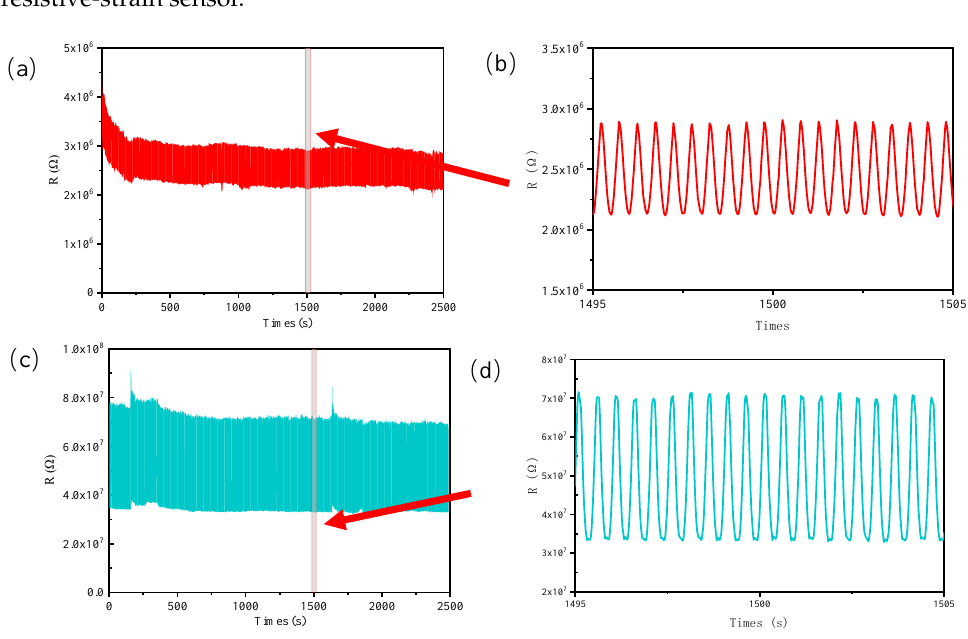
Figure 11. Responses of the untreated sensors and the sensors treated with low-temperature plasma to strain: ( a ) the change in the resistance of the untreated flexible sensor stretched 2500 times at 10% strain; ( b ) an enlarged view of the change in the resistance of the untreated flexible sensor; ( c ) the change in the resistance of the flexible sensor after plasma treatment under 10% strain after stretching 2500 times; ( d ) an enlarged view of the change in the resistance of the flexible sensor after plasma treatment.